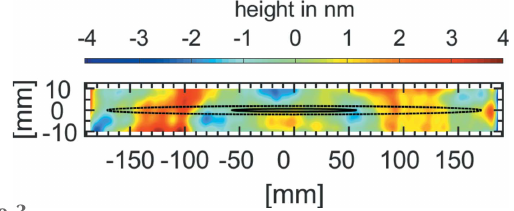
Figure 3 Surface profile of the Ni1 mirror. Characterized is the clear aperture of 370 mm (cid:6) 20 mm. The typical profile results in a concave radius of above 500 km and a slope error of 0.032 arcsec (r.m.s.) tangential and 0.038 arcsec (r.m.s.) sagittal. The 2 (cid:5) and 6 (cid:5) footprints of a FEL beam at 150 eV are drawn for reference according to Kuhlmann & Plo¨njes